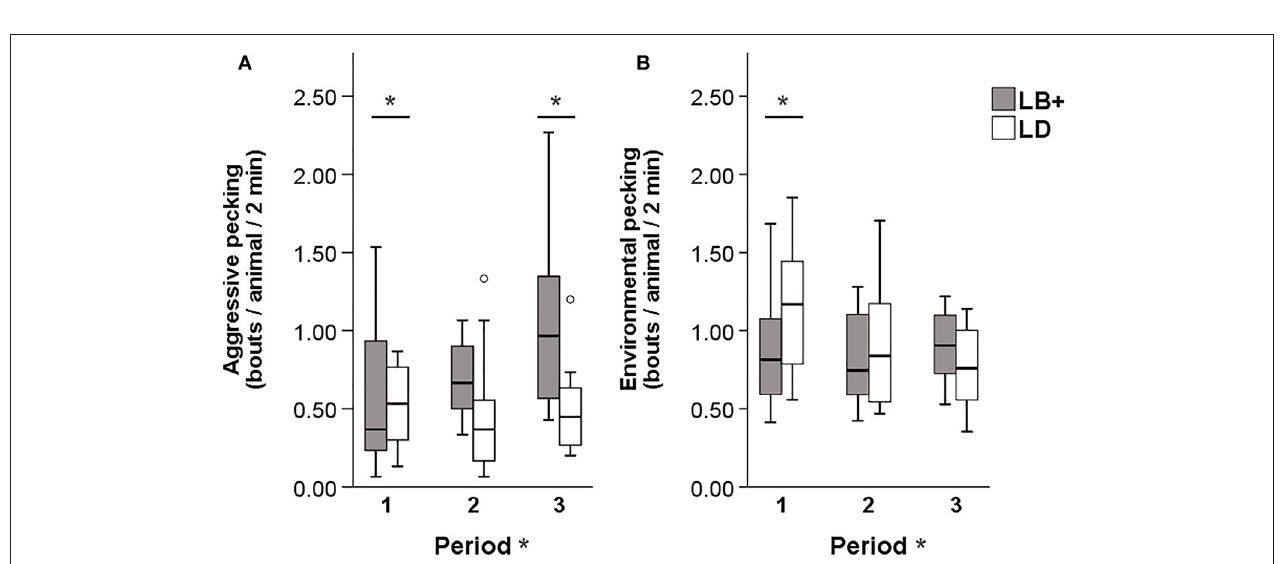
FIGURE 2 | Pecking behavior in conventional layer (LB + ) and dual-purpose (LD) hybrids at three times during the laying period (1: 25th − 30th, 2: 43rd − 48th, 3: 64th − 69th week of life). (A) Aggressive pecking, (B) environmental pecking. *Between bars denotes an effect of hybrid ( P < 0.05). *After “Period” denotes an effect of period ( P < 0.05). Both for aggressive pecking and environmental pecking a hybrid × period interaction was found ( P <